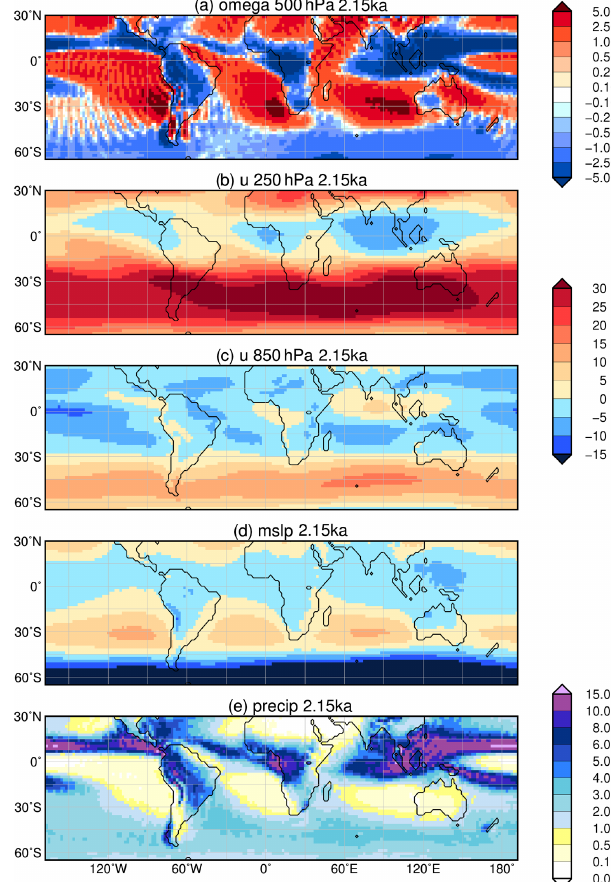
Figure B3. Simulated SON mean climate at 2.15ka, i.e. (a) vertical velocity (omega) in 500hPa (10 − 2 ms − 1 ) with blue colour show- ing uplift; (b) upper-tropospheric zonal wind ( u ) in 250hPa (ms − 1 ) with blue colours indicating easterly wind; (c) low-level zonal flow ( u ) in 850hPa (ms − 1 ); (d) mean sea level pressure anomaly (hPa) to standard atmospheric mean pressure (here 1013.25hPa), with blue colours indicating low-pressure systems; and (e) mean sea- sonal precipitation (mmd − 1